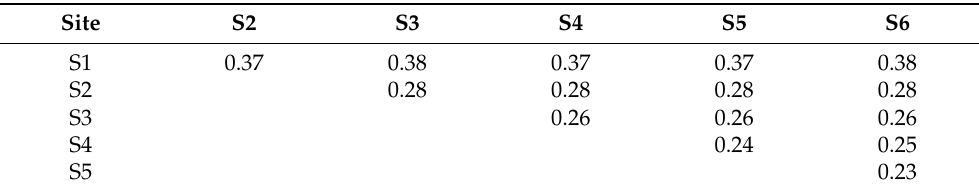
Table 2. Similarities in fungal community structures between the study sites (Sørensen qualitative similarity